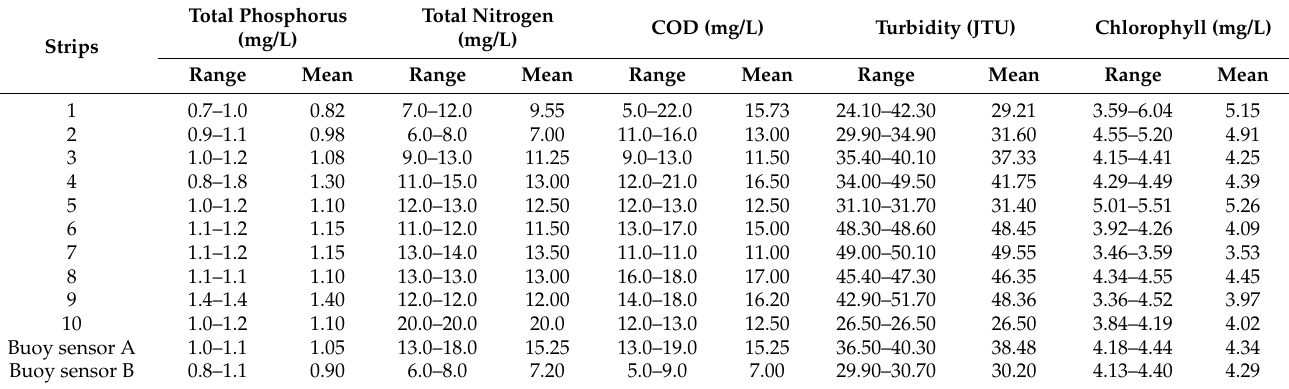
Table 1. Statistical values of water quality parameters of different strips consisting of 45 sampling test